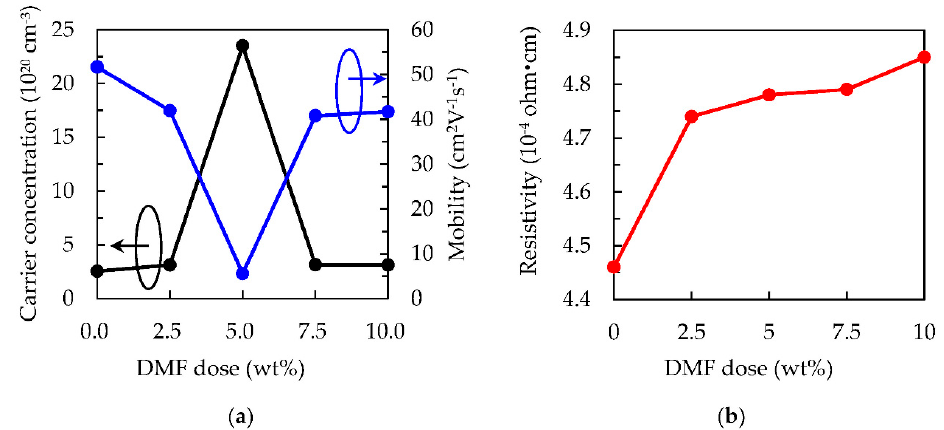
Figure 12. ( a ) Carrier concentration and mobility of the 350 °C-annealed TiO 2 film. ( b ) Resistivity determined by Hall effect measurement as a function of DMF doses from 0 to 10 wt%.